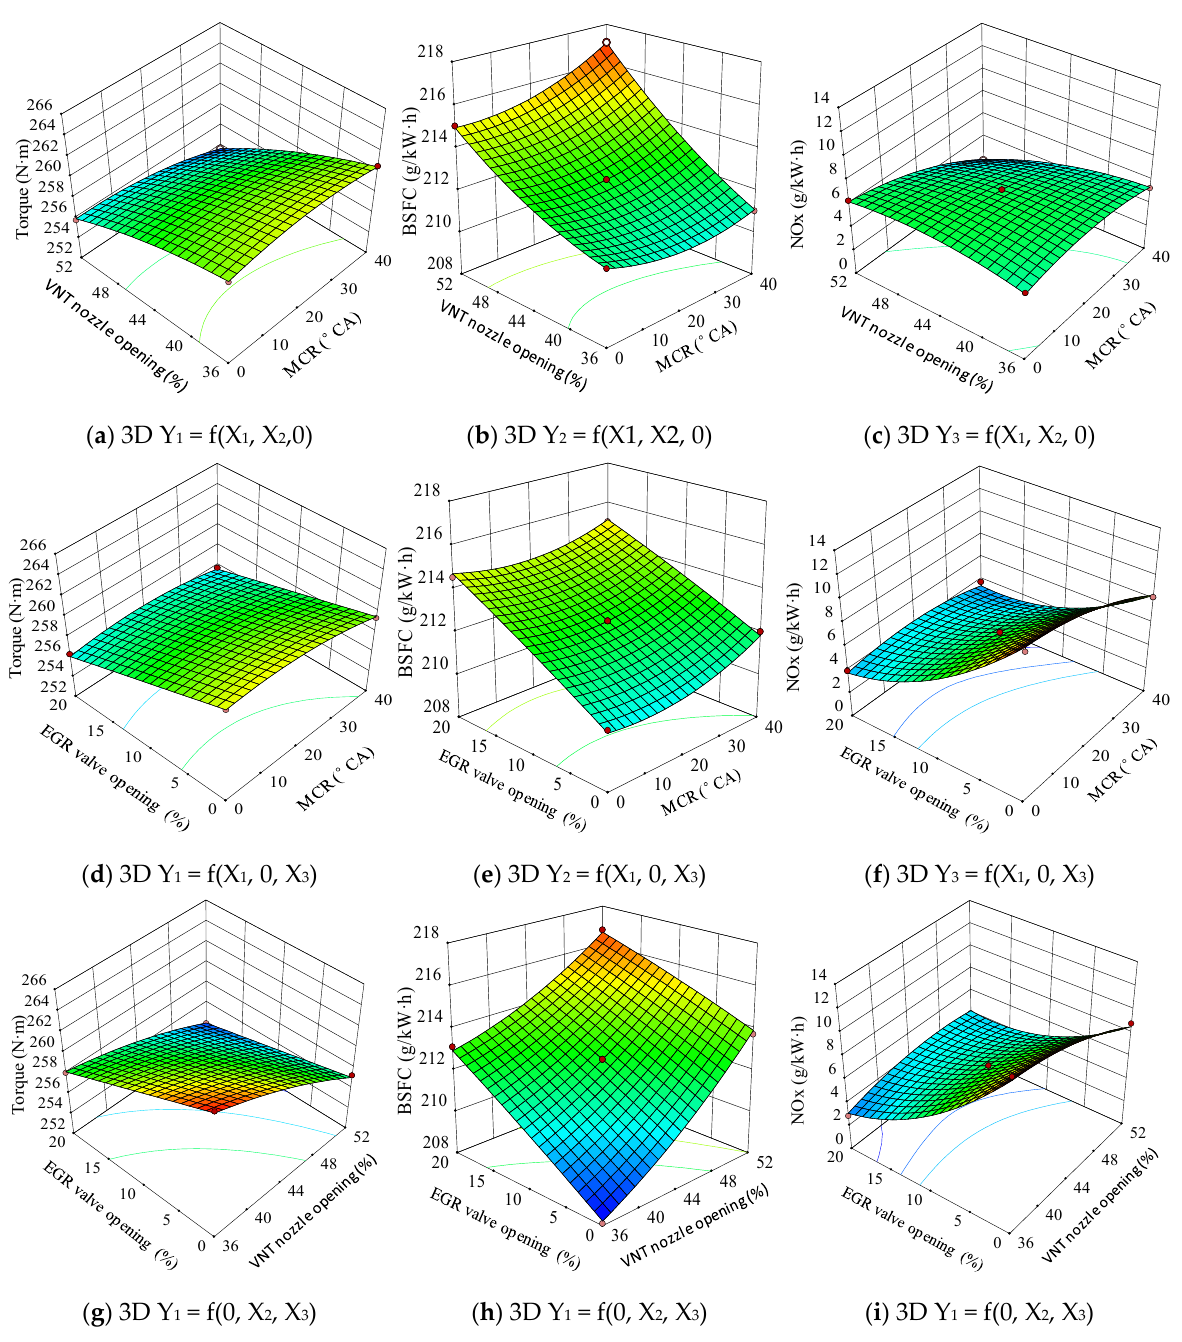
Figure 10. Influence of MEV coupling on the torque, BSFC, and NOx emission.